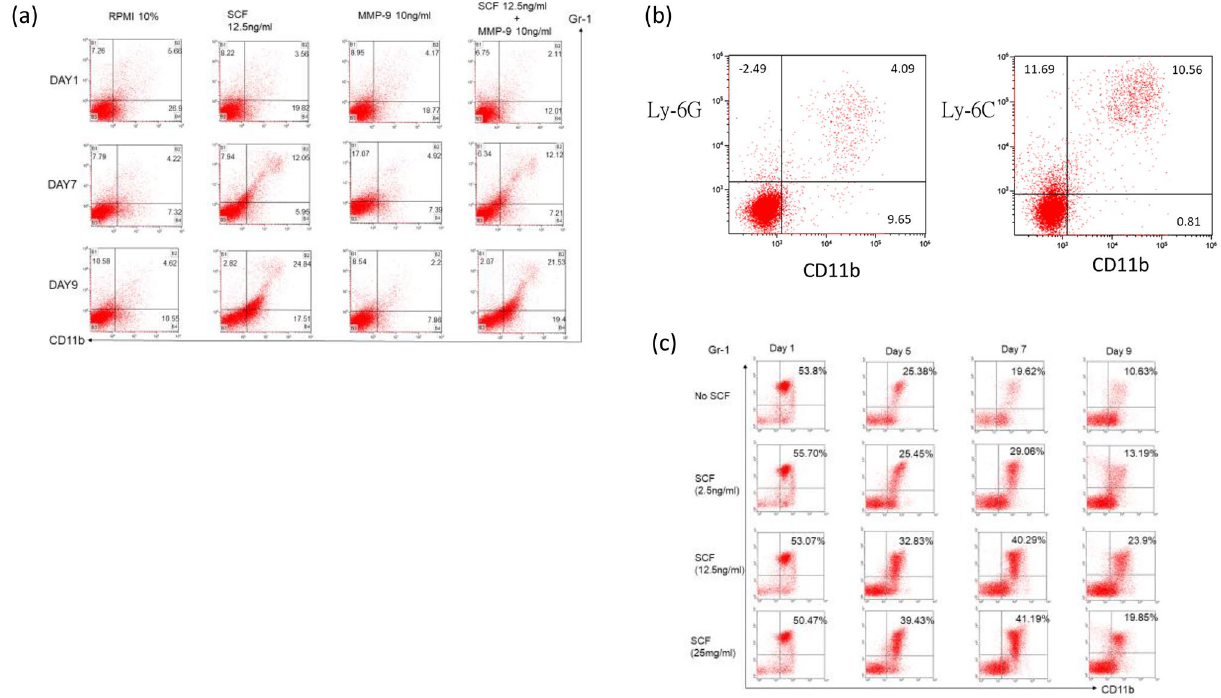
Figure 4. Representative MDSCs expanded and maintained by SCF. ( a ) Gr-1 + CD11b + cells appeared from day 7 of culture when 12.5 ng/ml recombinant mouse SCF was added to the culture medium. On day 9 of culture, approximately 25% of the cultured spleen cells were Gr-1 + CD11b + . Gr-1 + CD11b + cells were not increased when MMP-9 was added to the culture medium. ( b ) When large Gr-1 + CD11b + cells were gated, Ly-6C + cells were more prevalent than Ly-6G + cells. ( c ) The spleen cells harvested from tumor-bearing mice were cultured in RPMI-1640 and different doses of SCF were added. Gr-1 + CD11b + cells were diminished gradually if SCF was not added to the culture medium. The population of Gr-1 + CD11b + cells could be maintained when SCF (≥ 12.5 ng/ml) was added.